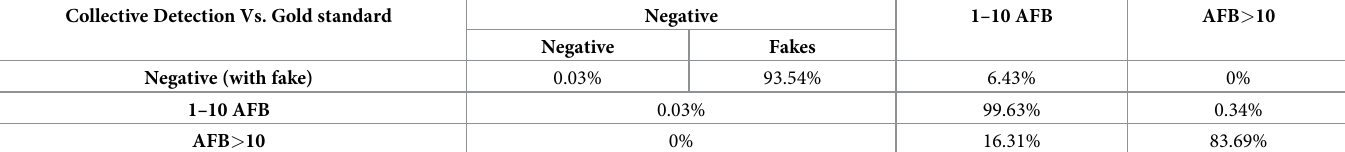
Table 1. Confusion matrix of the reference number of M . tuberculosis per image (rows) vs number of M . tuberculosis found by players (columns). Results shown in this matrix were achieved for a collective detection made by groups of 8 people with a quorum of 5.160 random groups of 8 players for each one of the FOVs. Numbers in the confusion matrix represent the percentage of the gameplays analyzed that were classified as a negative FOV (with zero bacillus), as a FOV with a fake bacillus, as a FOV with 1 to 10 bacilli or as a FOV with more than 10 bacilli. Collective Detection Vs. Gold